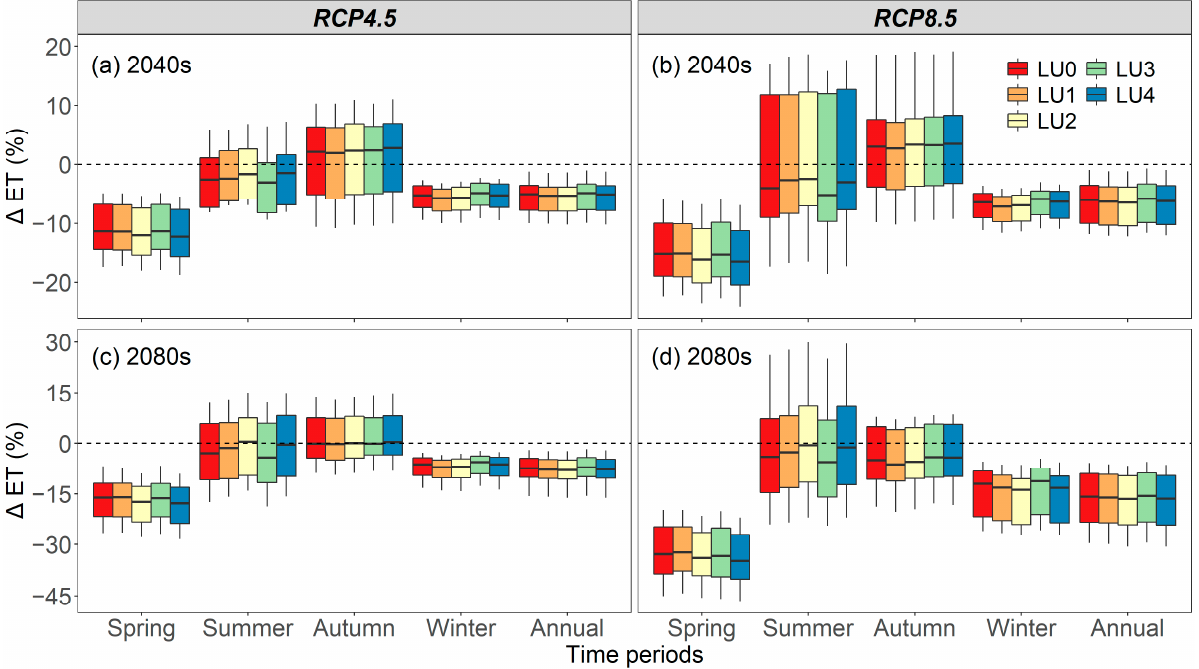
Figure 8. Projected seasonal and annual changes in ET (%) for LU0 − LU4 in the 2040s and 2080s under both RCPs estimated from 34 GCMs compared to the baseline period. Data displayed are changes in the 40 − year averages for each of the 34 GCMs. The lower and upper whiskers show the 10th and 90th percentiles; box boundaries show the 25th and 75th percentiles; the black line within each box marks the median values.